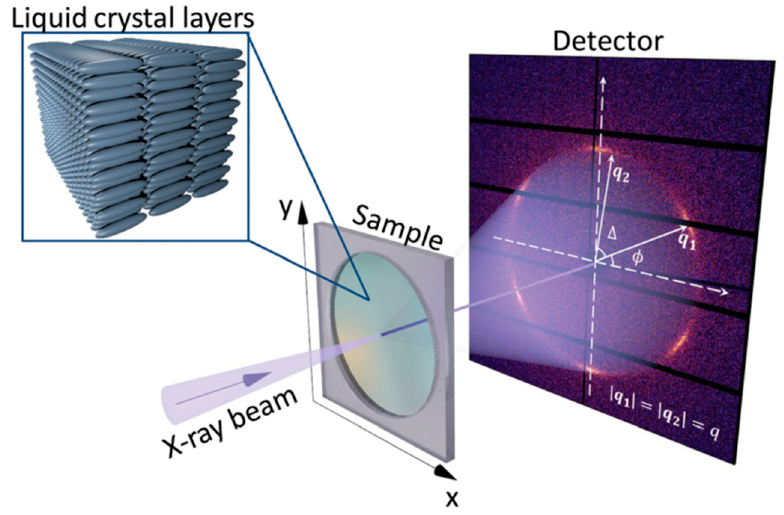
Figure 5. Scheme of the diffraction experiment on free standing liquid crystal (LC) films. The molecular layers are oriented parallel to the film surface, so the X-ray diffraction pattern corresponds to the in-plane order. (adopted from Zaluzhnyy et al. [17]—Published by The Royal Society of Chemistry). Used under CC-BY 3.0.